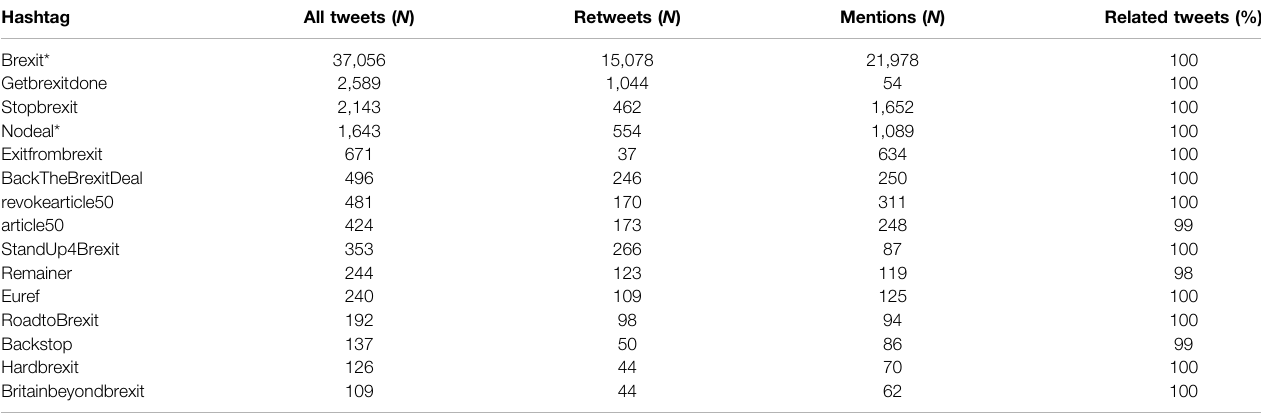
TABLE 1 | Hashtags used in the analysis. Retweets are excluded. Hashtag All tweets ( N